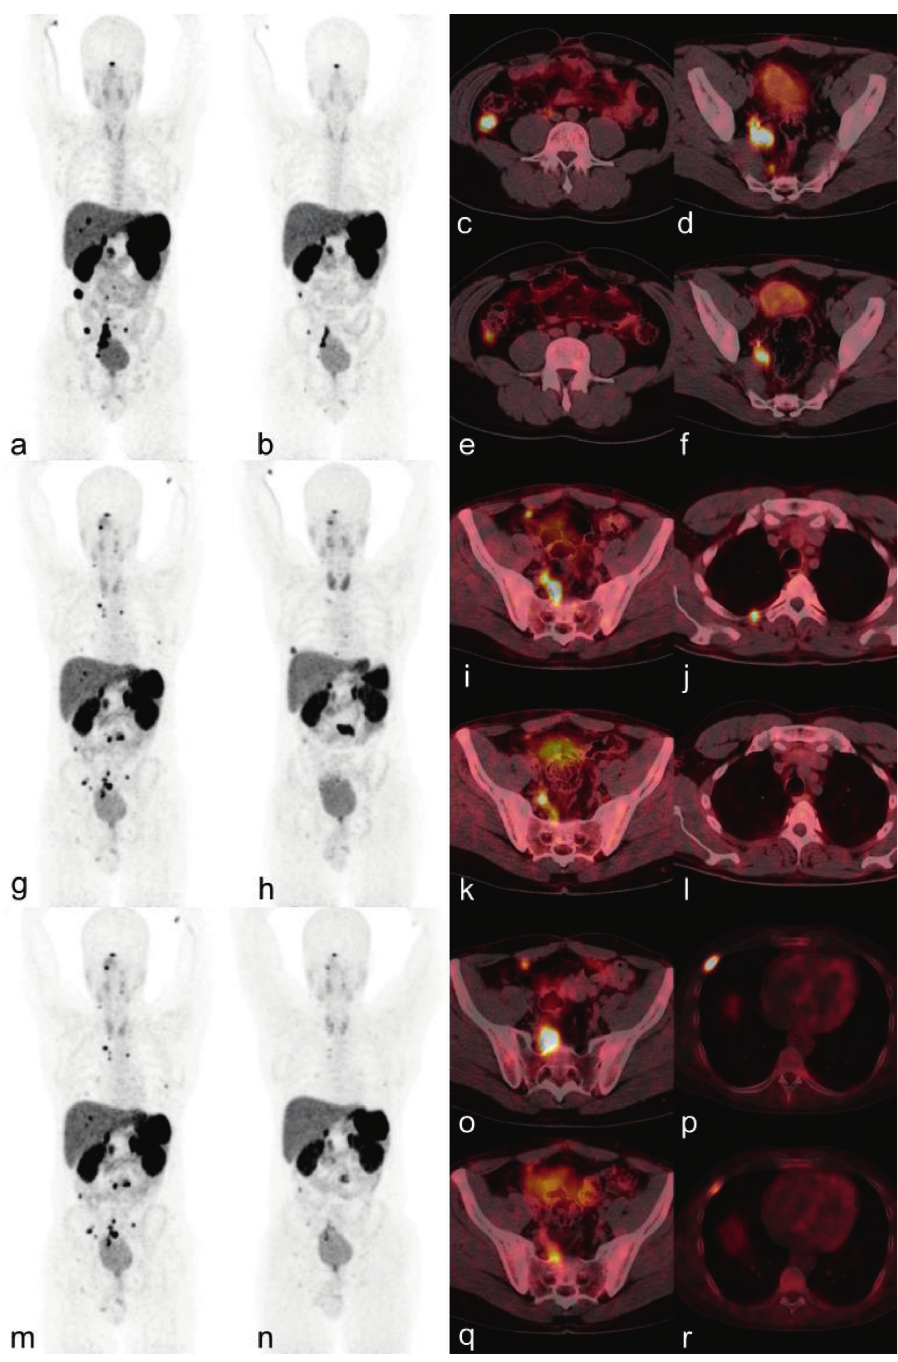
Figure 3: Example of the effect of the repeated tandem [ 90 Y]Y/[ 177 Lu]Lu-DOTATATE therapy: a 30-year-old man with a nonfunctional rectal G2 NET after surgery for primary tumours, with progression of the disease after 43 months. The [ 68 Ga]Ga-DOTATATE PET/CT carried out for qualification to the PRRTshowed increased uptake (higher than in the liver) in multiple, disseminated metastases. The patient received the initial PRRT, repeated PRRT, and re-repeated PRRTwith the total accumulated injection activity of 29.6GBq. The PFS rate after the I-PRRT, R-PRRT, and RR-PRRTwas 35, 19, and 13 months, respectively. The disease progression after each therapy course was observed in different parts of the body. (a) [ 68 Ga]Ga-DOTATATE PET MIP (maximum intensity projection) before the I-PRRT showing uptake in multiple metastases; (b) [ 68 Ga]Ga-DOTATATE PET MIP after the I-PRRT showing partial response to the treatment; and axial fusion [ 68 Ga]Ga-DOTATATE PET/CT (c, d) before and (e, f) after the I-PRRT. (g) [ 68 Ga]Ga-DOTATATE PET MIP before the R-PRRTshowing progression of the disease after the I-PRRT; (h) [ 68 Ga]Ga-DOTATATE PET MIP after the R-PRRT showing partial response to the treatment; and axial fusion [ 68 Ga]Ga-DOTATATE PET/CT (i, j) before and (k, l) after the R-PRRT. (m) [ 68 Ga]Ga-DOTATATE PET MIP before the RR-PRRTshowing progression of the disease after the R-PRRT; (n) [ 68 Ga]Ga-DOTATATE PET MIP after the RR-PRRTshowing partial response to the treatment; and axial fusion [ 68 Ga]Ga-DOTATATE PET/CT (o, p) before and (q, r) after the